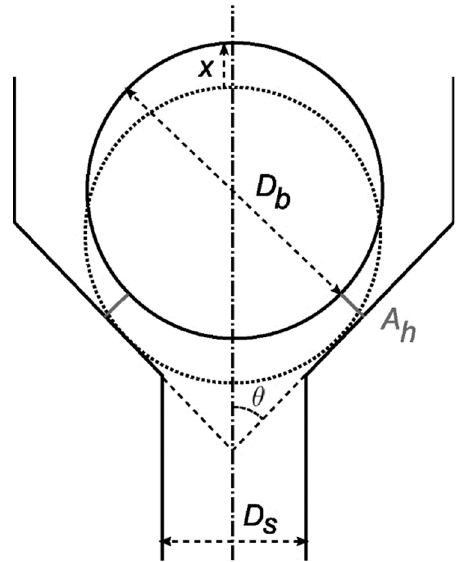
Figure 3. Geometry of the ball check valve [30]. D S —diameter of the flow section from the compression chamber; D b —ball diameter; A h —fluid passage area between the ball and the seat depending on x; x —height of the valve opening (lift); θ —seat angle relative to the axis of symmetry.